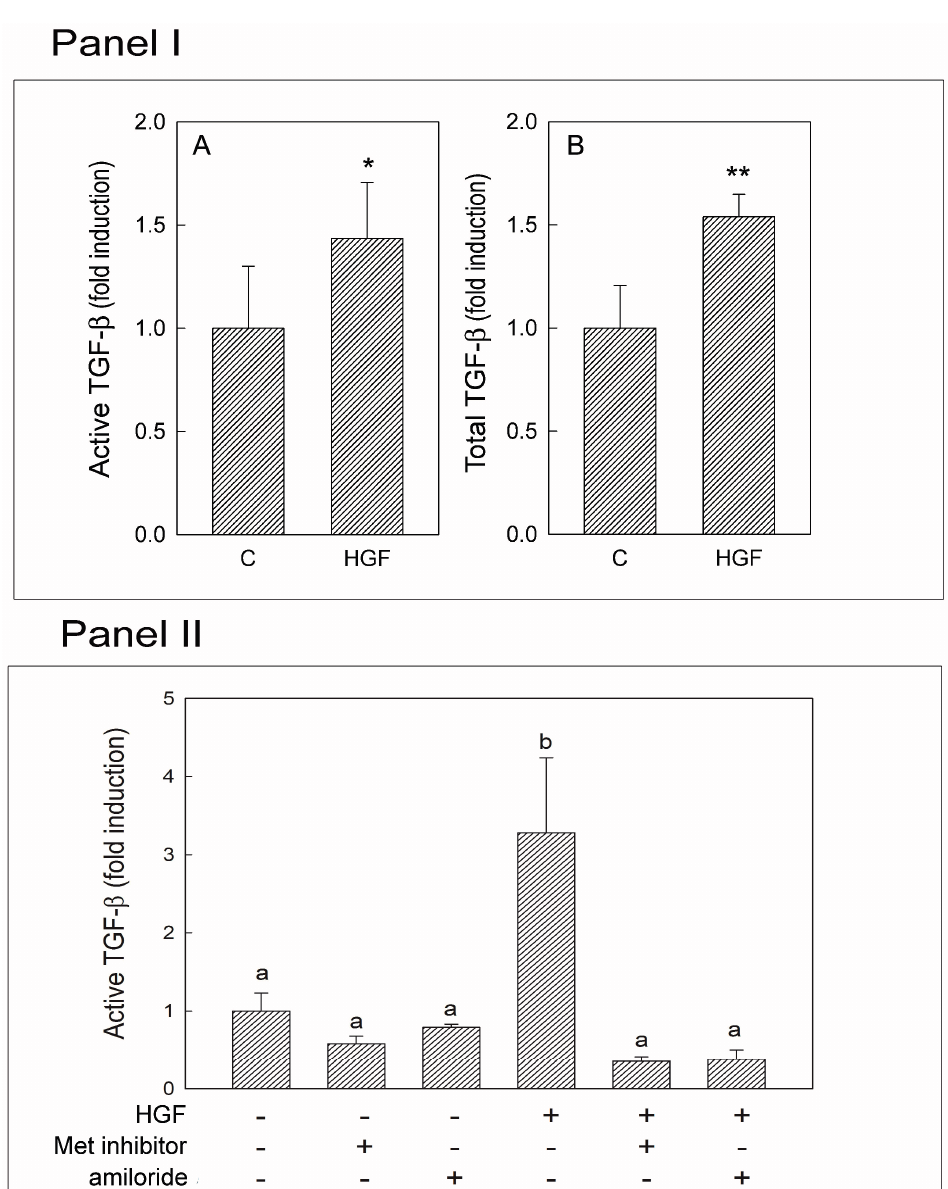
Figure 8. HGF dependent TGF- β secretion and activation in purified myoid cells and in cultured seminiferous tubules. ( I ): TGF- β secreted by purified myoid cells. The amounts of active ( A ) and total ( B ) TGF- β in the control C and HGF-treated samples are shown. The values represent the mean ± SEM of four different experiments and are expressed as fold induction with respect to the control, which was arbitrarily set to one. * p < 0.05; ** p < 0.01; ( Panel II ): Active TGF- β secreted by cultured tubular fragments at Stages VI–VIII of the seminiferous epithelium cycle. The amounts of active TGF- β secreted in the control condition and after HGF administration are shown. The effect on TGF- β activation due to amiloride or Met inhibitor administered alone or in combination with HGF is also reported. The values represent the mean ± SEM and are expressed as fold induction with respect to the control, which was arbitrarily set to one. a vs. b p < 0.01; the same letters indicate values that are not statistically